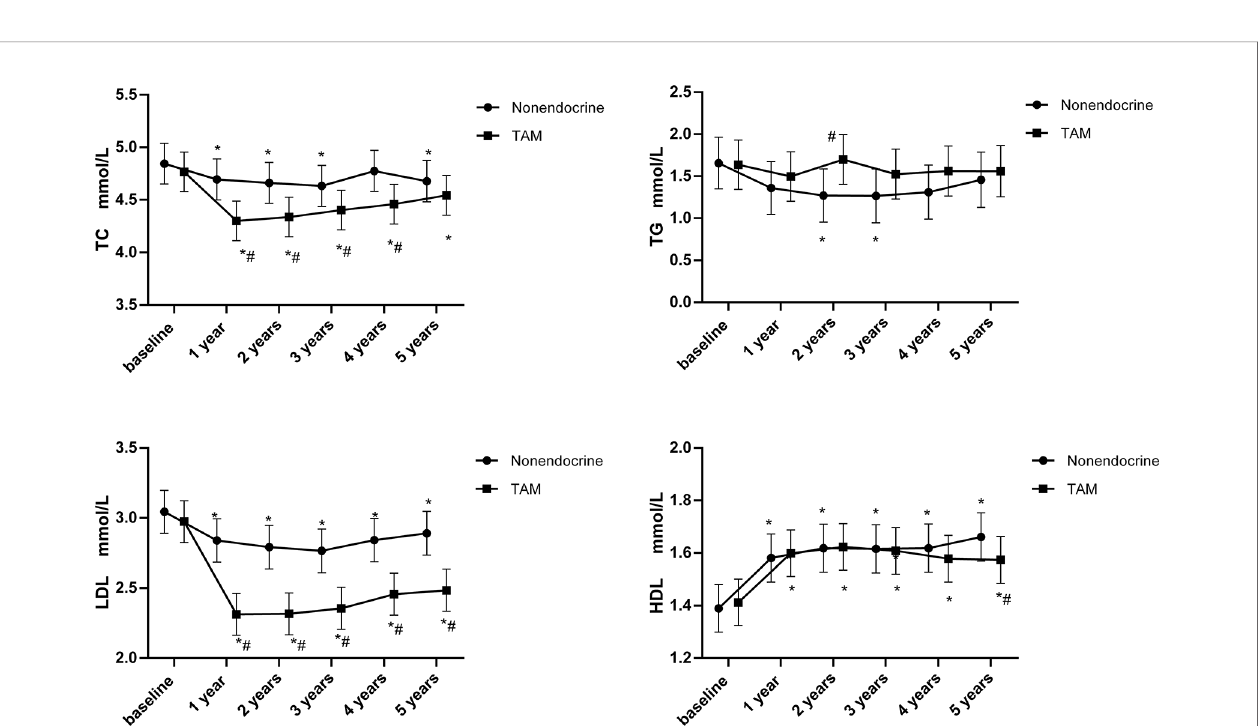
FIGURE 2 | Line chart of lipid pro fi les during 5-years endocrine therapy in premenopausal BC patients. * p < 0.05 for comparison with baseline. # p < 0.05 for comparison with the nonendocrine